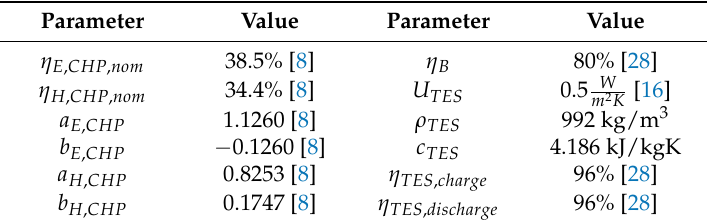
Table 2. Technical characteristics and thermophysical properties.